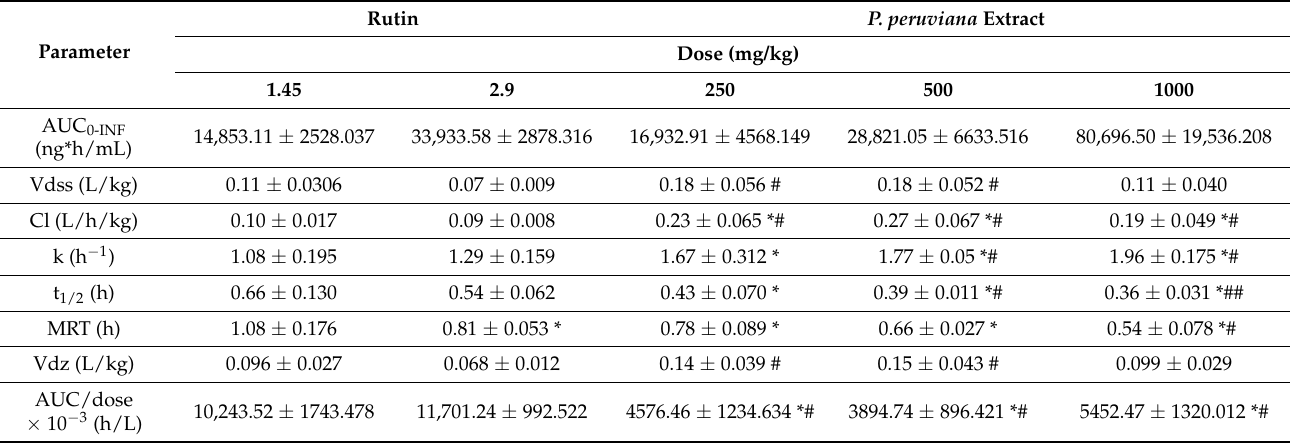
Figure 2. Plasma concentration–time curves. ( a ) Rutin after intravenous administration of the pure compound. ( b ) Quercetin representing the metabolites quercetin-3- O -glucuronide (Q3OG) and quercetin-3- O -sulfate (Q3OS) after oral administration of pure rutin. ( c ) Rutin after intravenous ad- ministration of the extract of calyces of Physalis peruviana . ( d ) Quercetin representing the metabolites Q3OG and Q3OS after oral administration of the extract of calyces of P. peruviana . Data are expressed as the mean ± standard error of the mean ( n = 5). Table 2. Pharmacokinetic parameters from non-compartmental analysis after intravenous administration of pure rutin and extract of calyces of Physalis peruviana